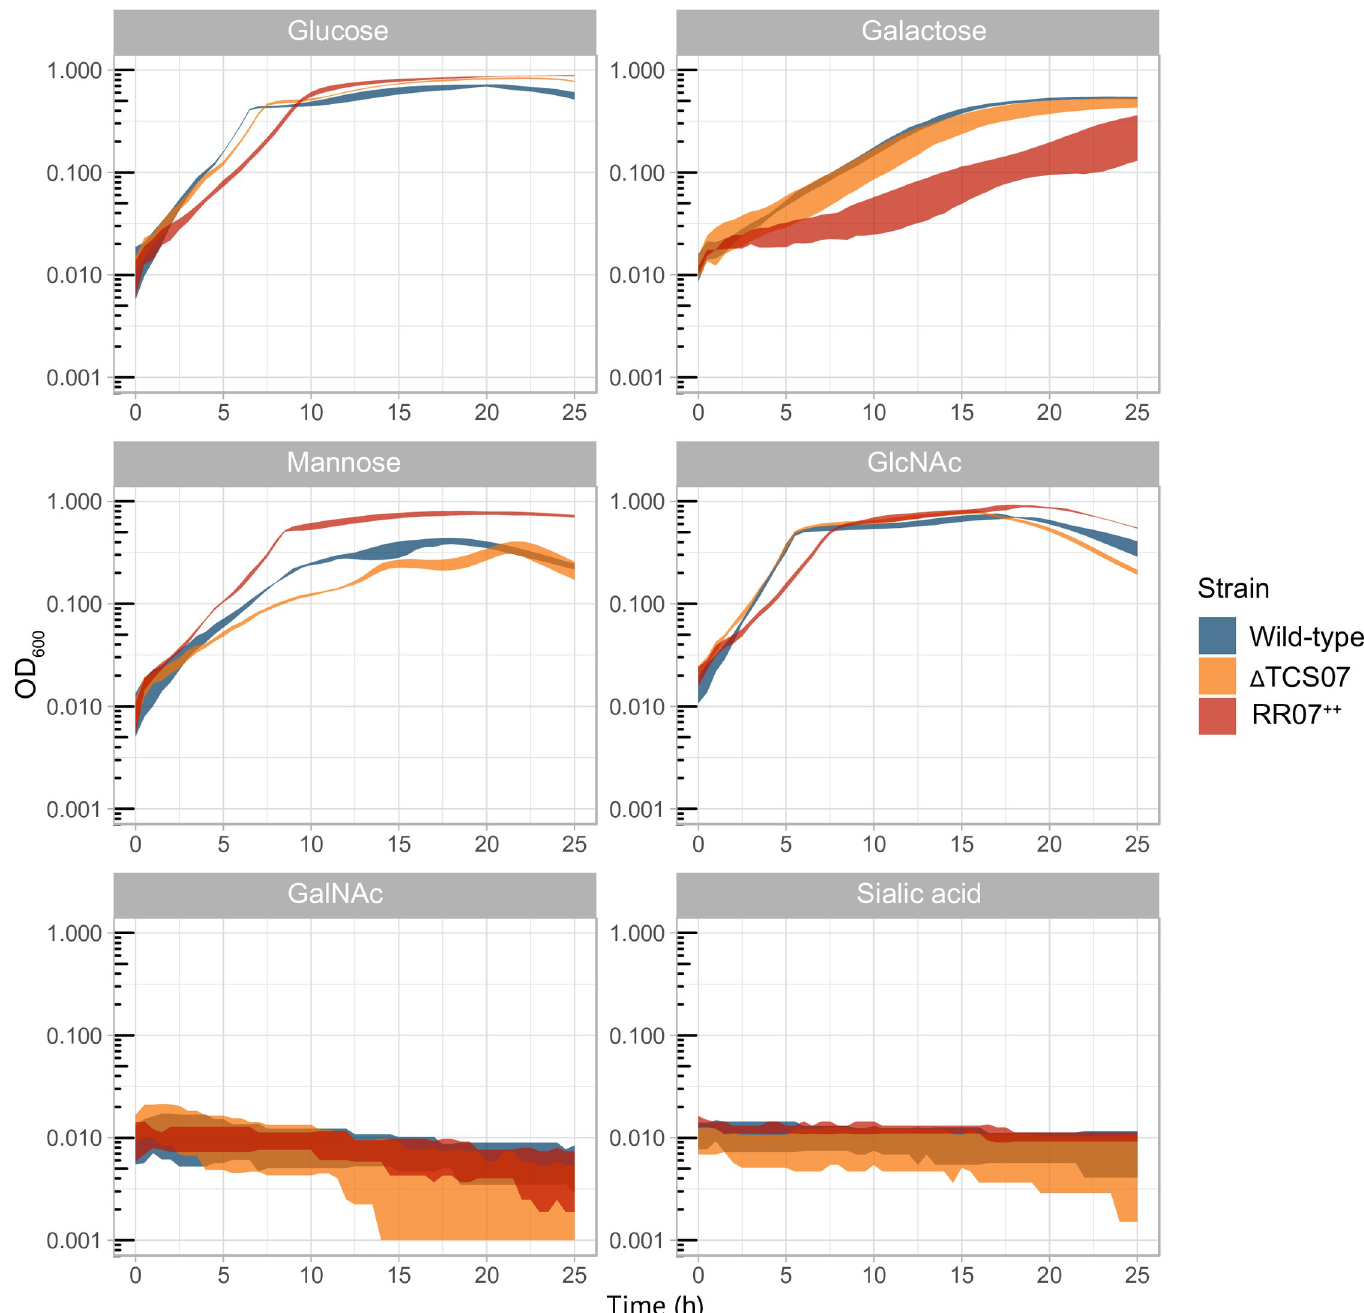
Fig 3. Growth experiments in glycan-derived sugars. Indicated strains were grown to exponential phase (OD 600 = 0.3–0.4) in C+Y, at which point they were spun down and resuspended to OD 600 = 0.1 in PBS. 20 μ L was added to 180 μ L CDM supplemented with 0.5% of the indicated sugar. Standard deviation depicted as colored-shadow. Performed in triplicates at least three independent